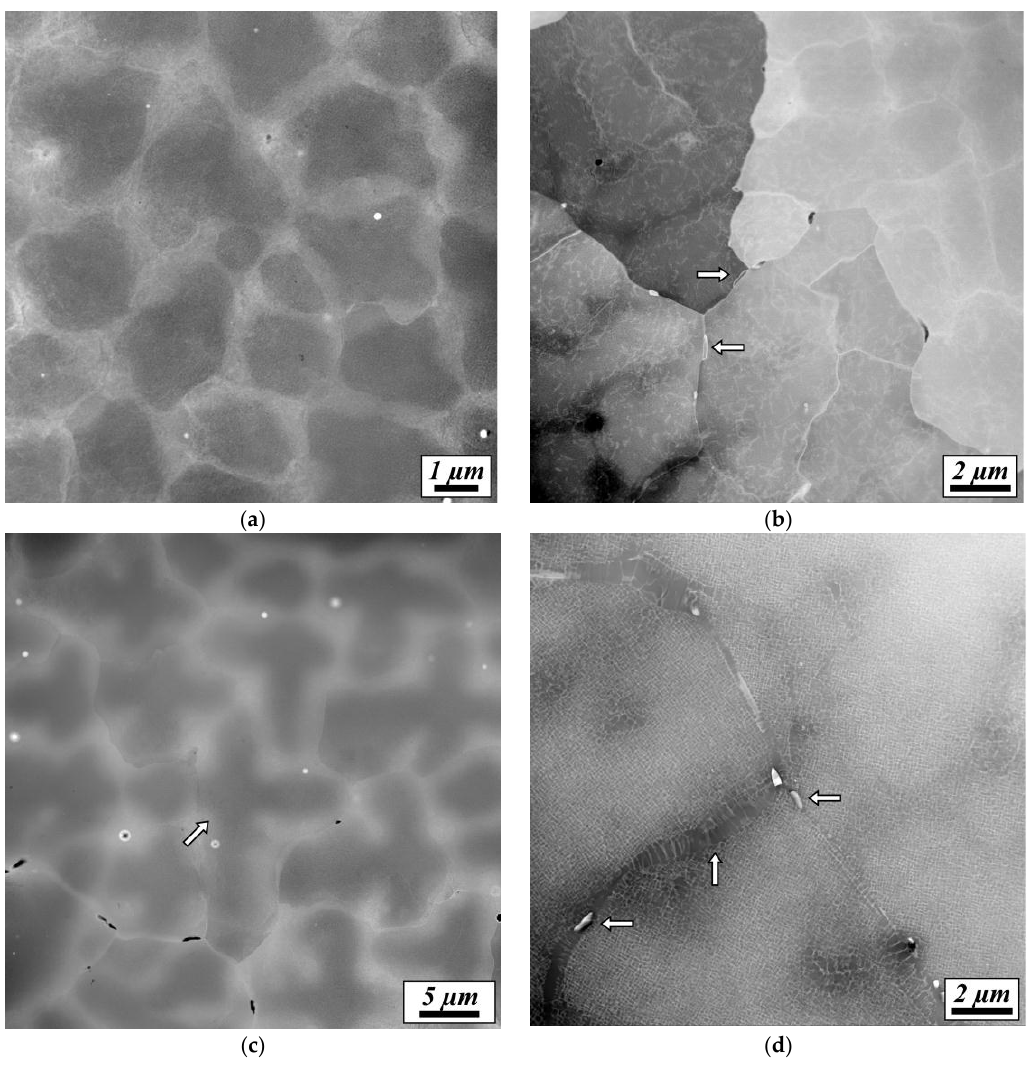
Figure 6. STEM-HAADF images showing the microstructures of materials states A and B: ( a ) higher magnification image of SEBM material A; ( b ) SEBM material A at a lower magnification; ( c ) low magnification image of SEBM material B; and ( d ) SEBM material B at a higher magnification.